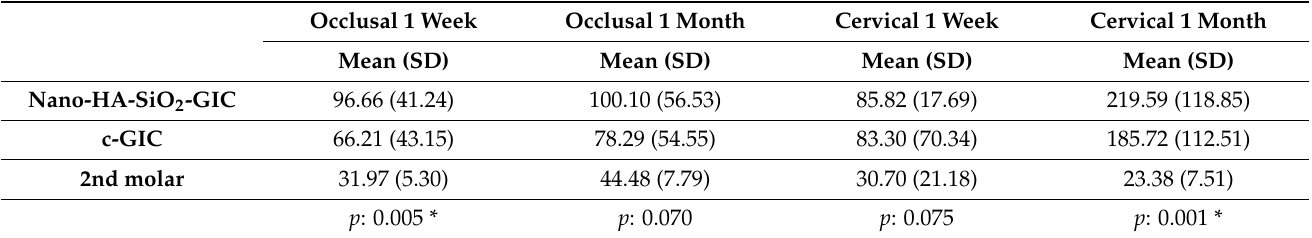
Table 4. Comparisons of tertiary dentin thickness of nano-HA-SiO 2 -GIC, c-GIC, and 2nd molar (negative control) on various days using one-way